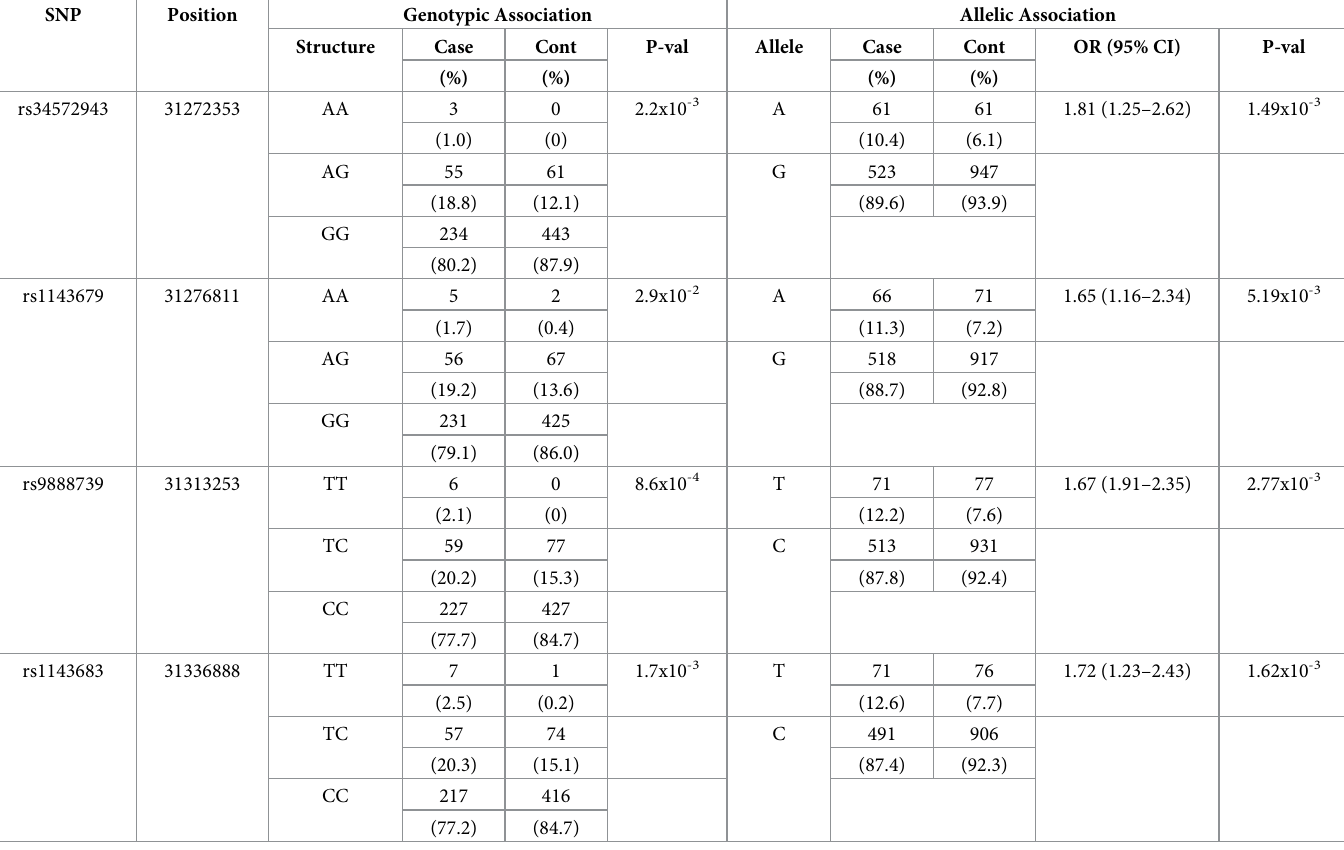
Table 1. Genotypic and allelic frequencies of the ITGAM polymorphisms and association analysis in patients with SLE and controls from Central Me´xico. SNP